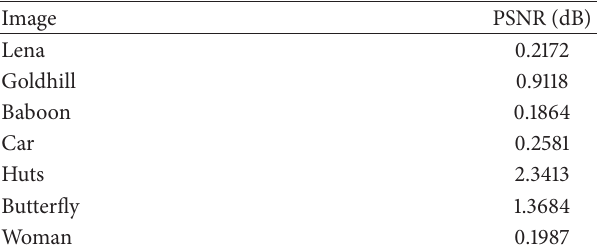
Table 2: PSNR obtained for various